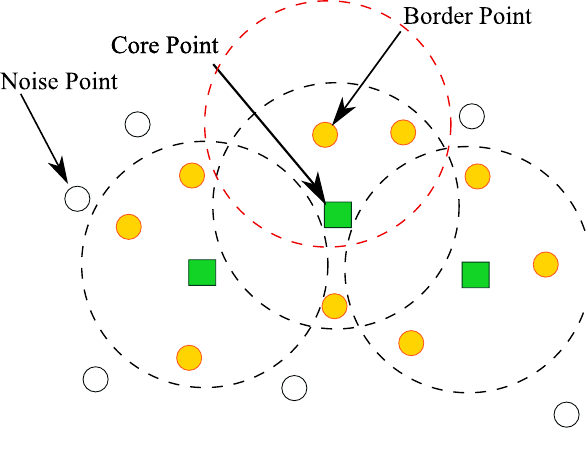
Figure 1. DBSCAN Image.